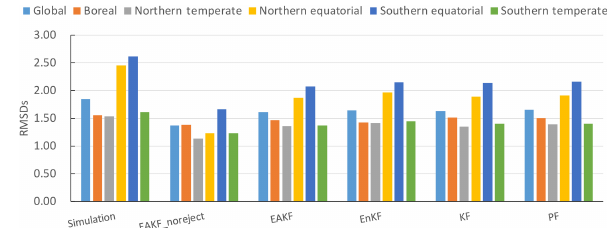
Figure 5. Globally or regionally averaged RMSDs for the simula- tion and assimilation results and GEOV2